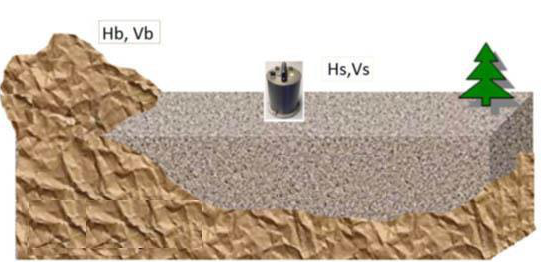
Figure 2 . Soil layer and bedrock layer strain relation (reproduced from Nakamura,